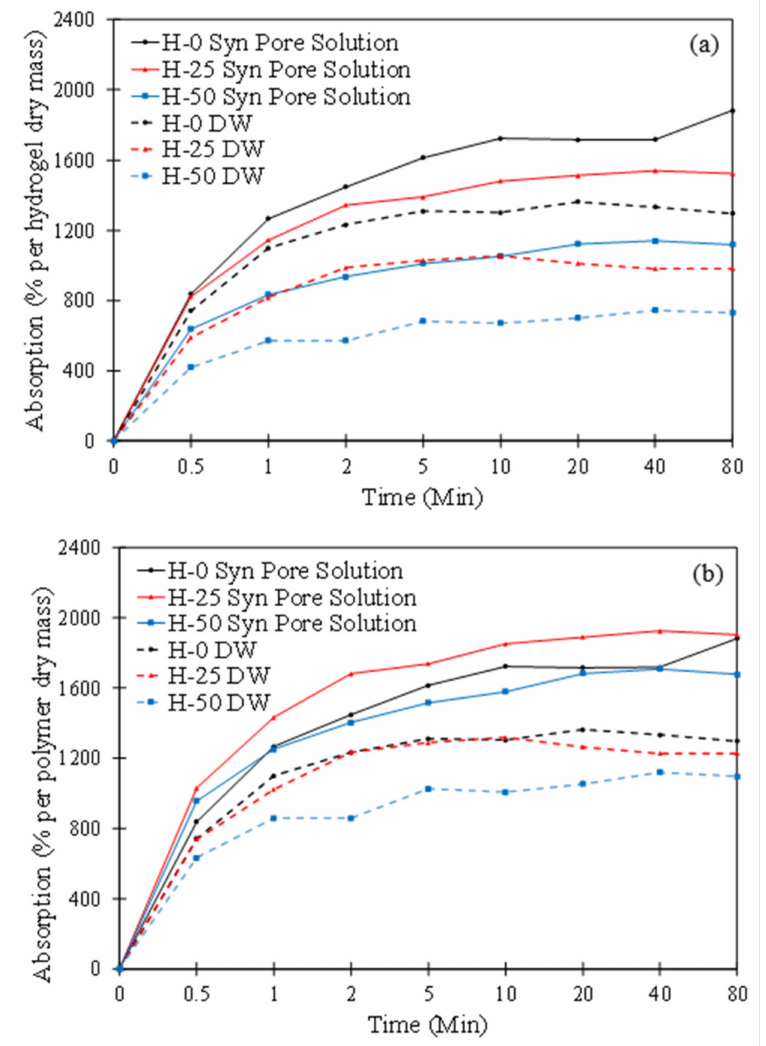
Figure 3. Hydrogel absorption calculated ( a ) per dry mass of polymer and nanosilica and ( b ) per dry mass of polymer only in distilled water (DW) and in the synthetic pore